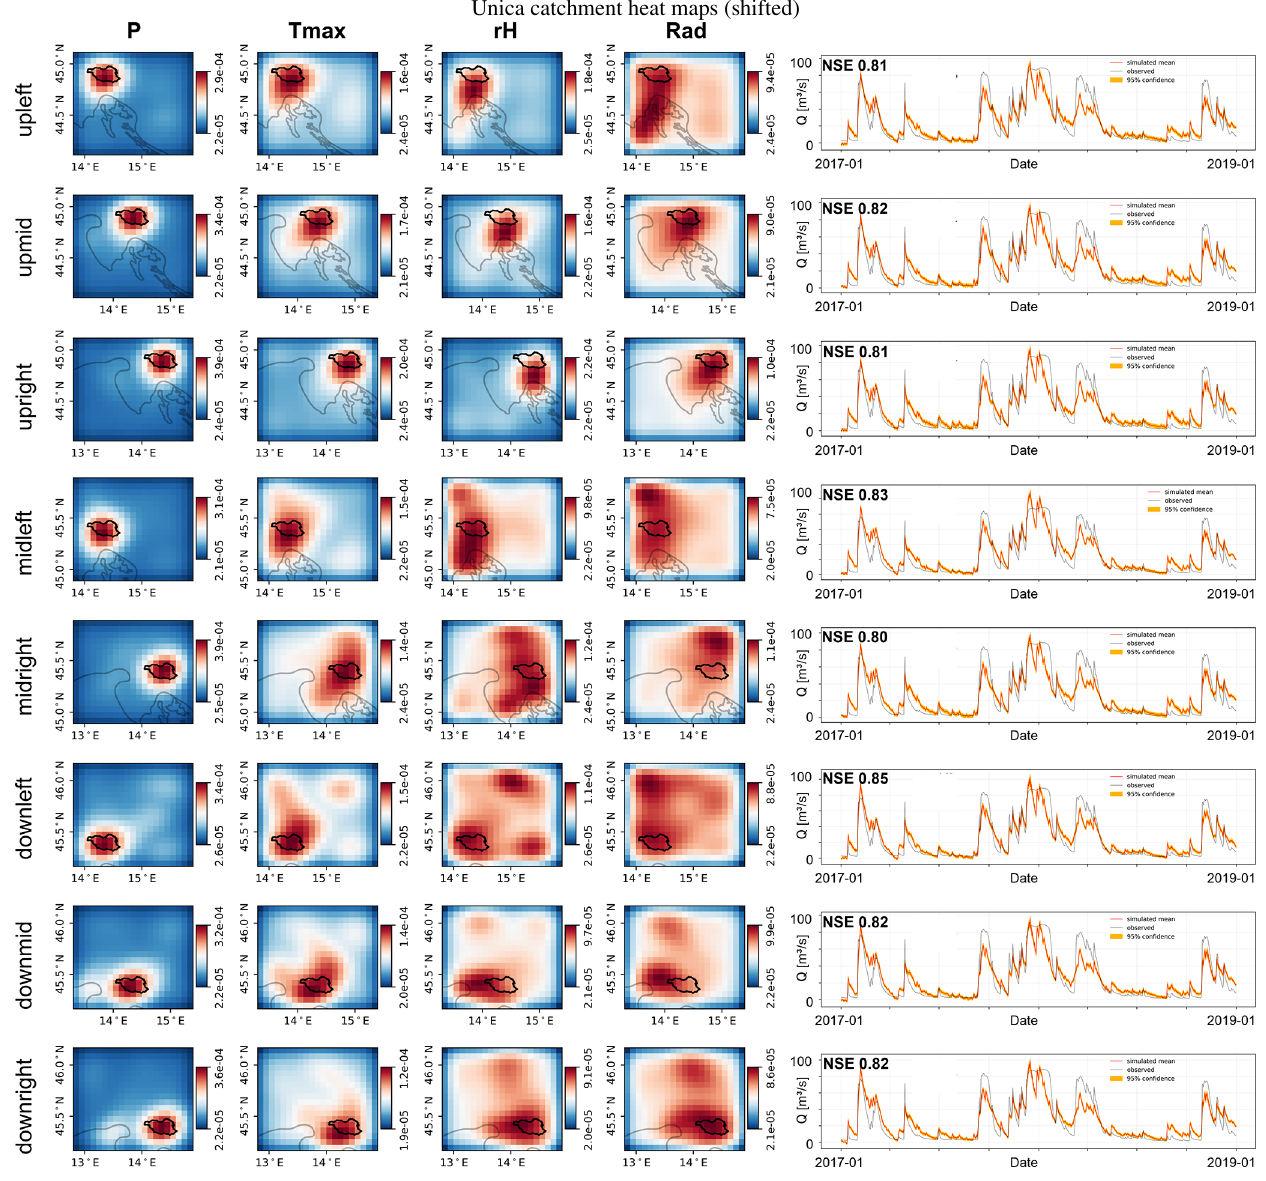
Figure 7. Heat maps of spatial input sensitivity for the Unica springs catchment based on E-OBS gridded data. The considered area of the gridded input data is shifted to demonstrate the spatial learning capabilities of the